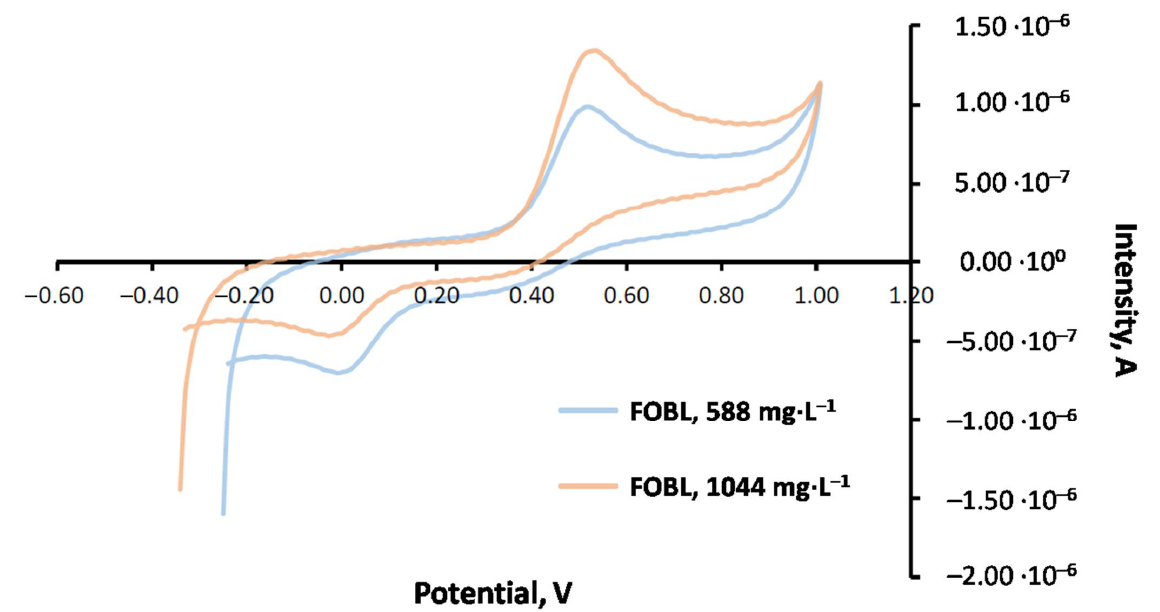
Figure 7. Cyclic voltammograms (150 mV · s − 1 ) obtained in emulsion medium for FOBL at different TBHQ concentrations (588 and 1044 mg · L − 1 ). Final concentrations in the cell: 11.76 and 20.88 mg · L − 1 , respectively.